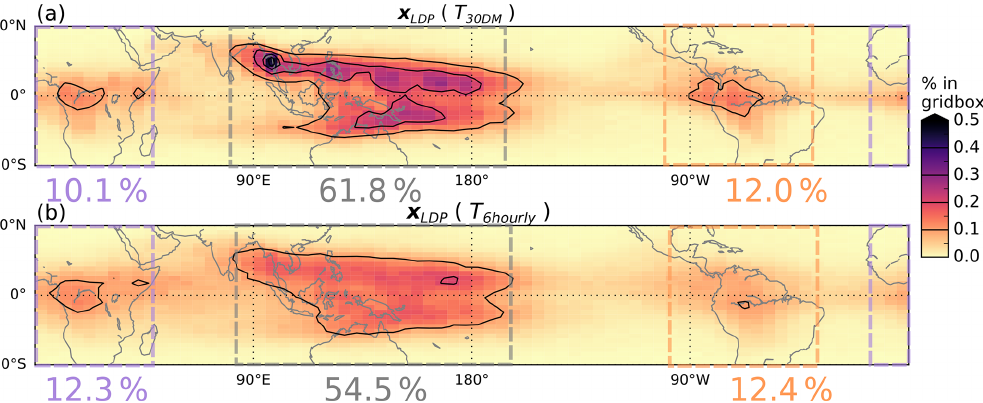
Figure 9. Spatial distribution of Lagrangian dry point events for trajectories subject to (a) 30d mean temperature field and (b) 6-hourly temperatures. The colours show the percent of all LDP events within 4.5 ◦ × 2 ◦ grid boxes, with black contours plotted every 0.1%. The numbers give the cumulative percentages within the coloured